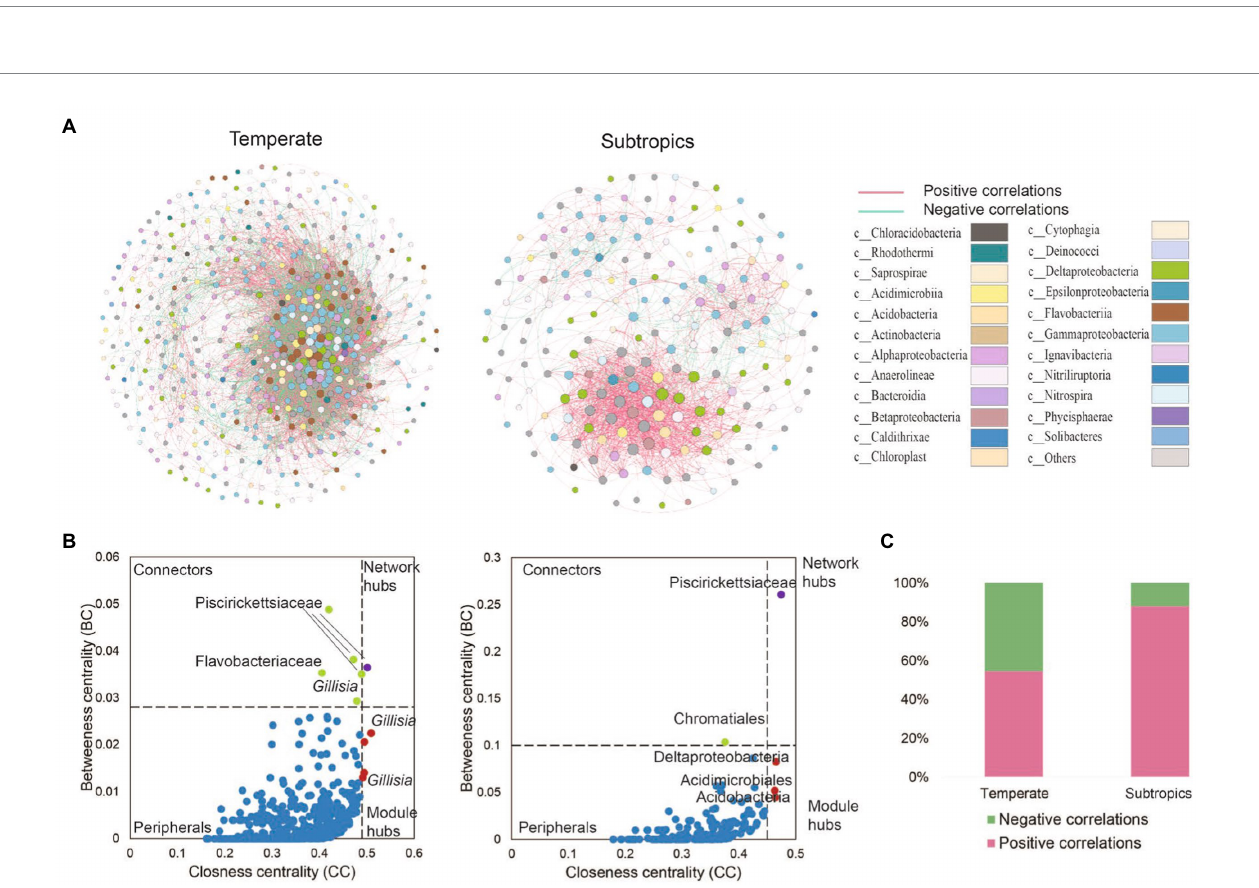
FIGURE 4 (A) The co-existence networks of bacterial co-occurrence patterns and (B) keystone hubs in different climates zones. Keystone hubs were visualized based on betweenness centrality (BC) and closeness centrality (CC) in the network of different treatments. In the temperate network, the module hubs were defined as BC < 0.028 and CC > 0.49, the network hubs as BC > 0.028 and CC > 0.49, the connectors as BC > 0.028 and CC < 0.49, and the peripherals as BC < 0.028 and CC < 0.49. In a subtropical network, the module hubs were defined as BC < 0.028 and CC > 0.49, the network hubs as BC > 0.1 and CC > 0.45, the connectors as BC > 0.1 and CC < 0.45, and peripherals as BC < 0.10 and CC < 0.45. (C) The proportion of positive and negative correlations detected in temperate and subtropical salt